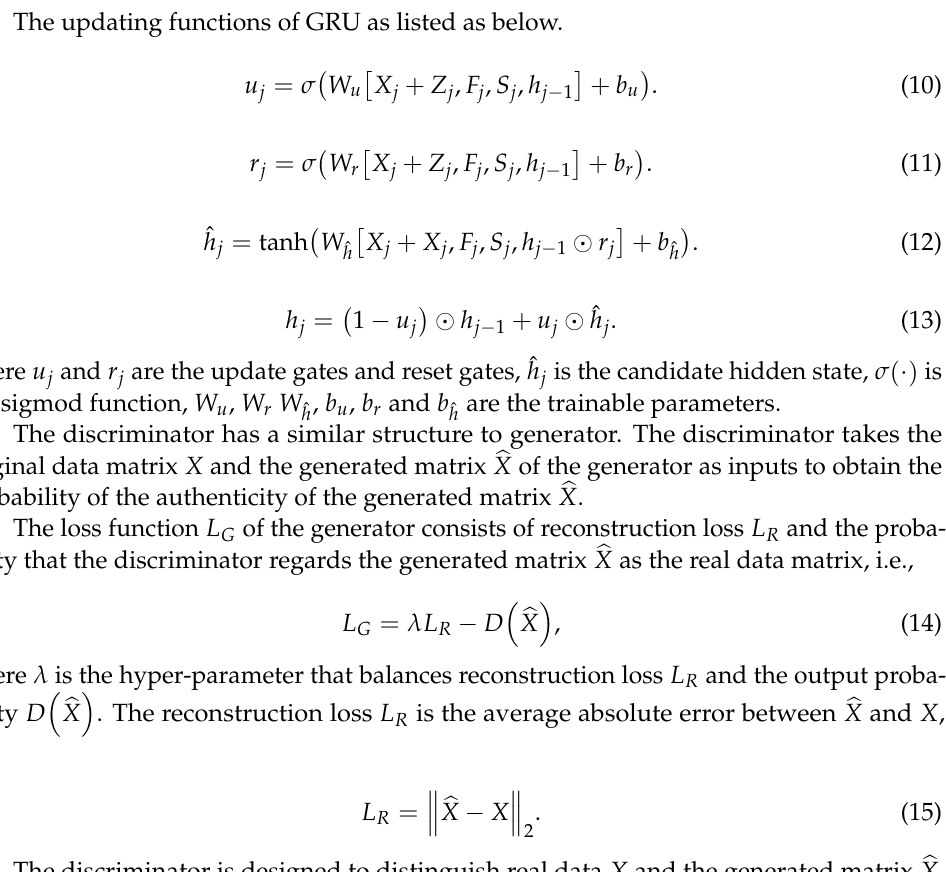
Figure 9. The structure of GRU unit, where (cid:12) is Hadamard product, and ⊕ is the concatenation